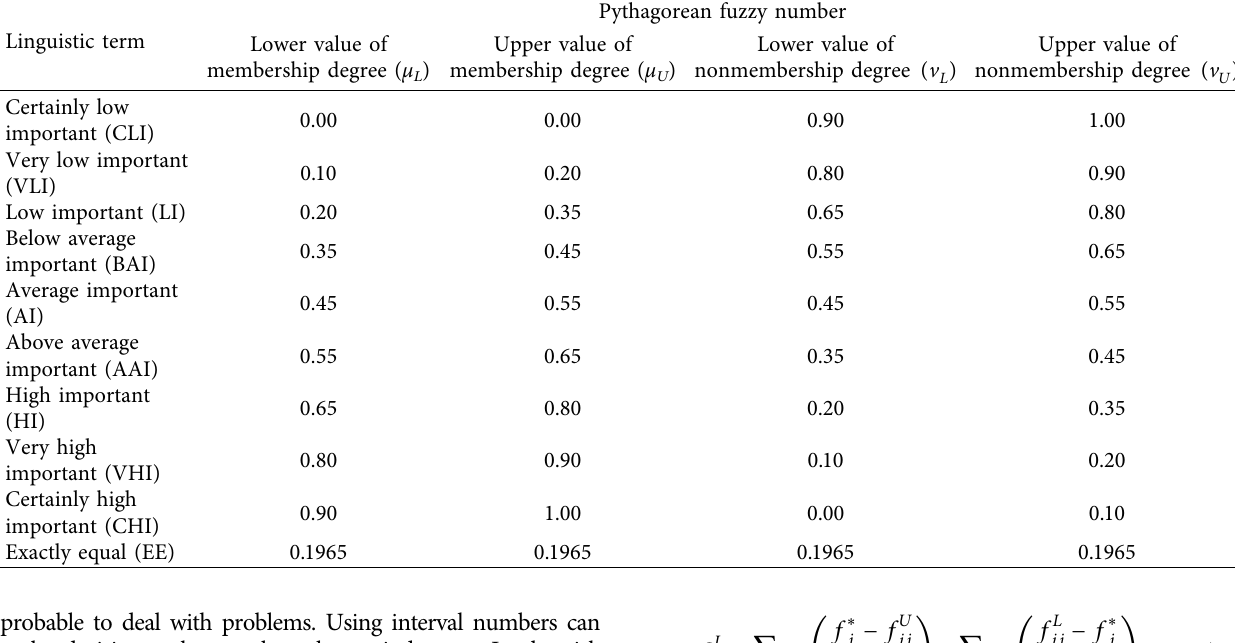
Table 1: Weighting scale for PAHP